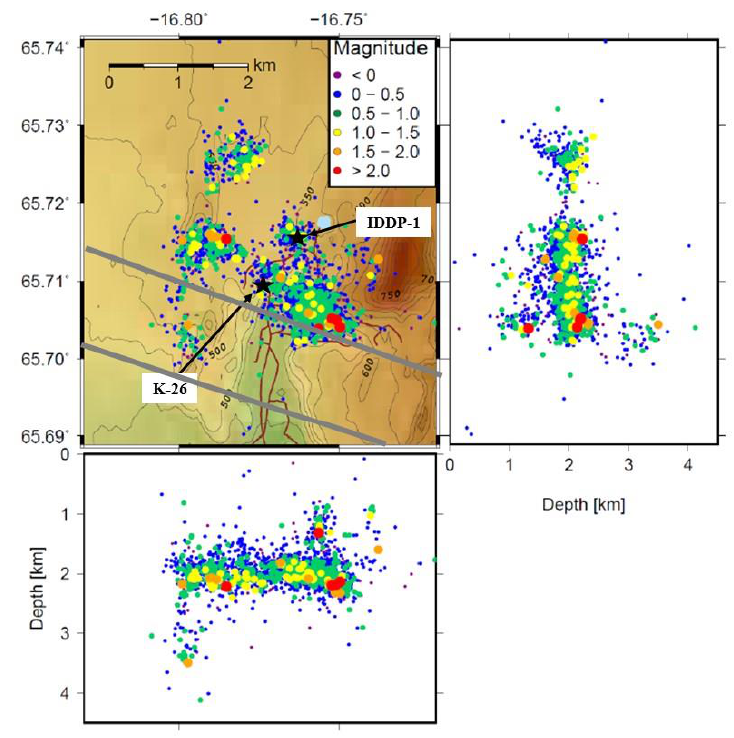
Figure 11. Earthquakes located in Krafla from November 2015 to November 2016. The map also shows the location of reinjection wells (K-26 and IDDP-1) and the transverse gravity low (grey lines) (modified from [32]).